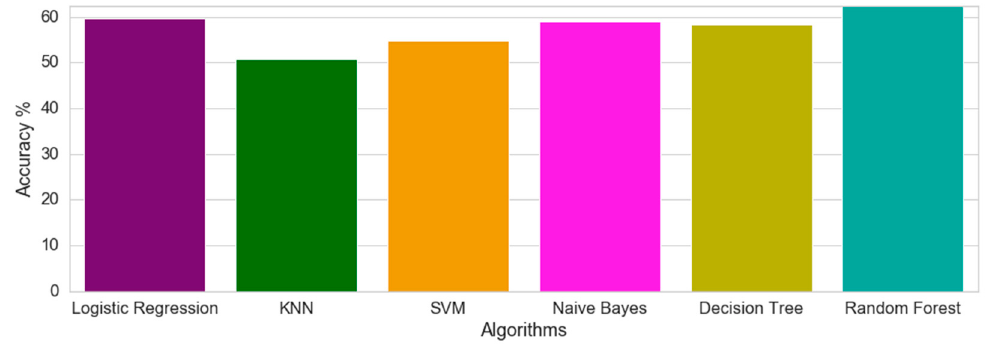
Figure 15. Algorithm accuracy comparison for Dataset 2, with fourteen independent variables.